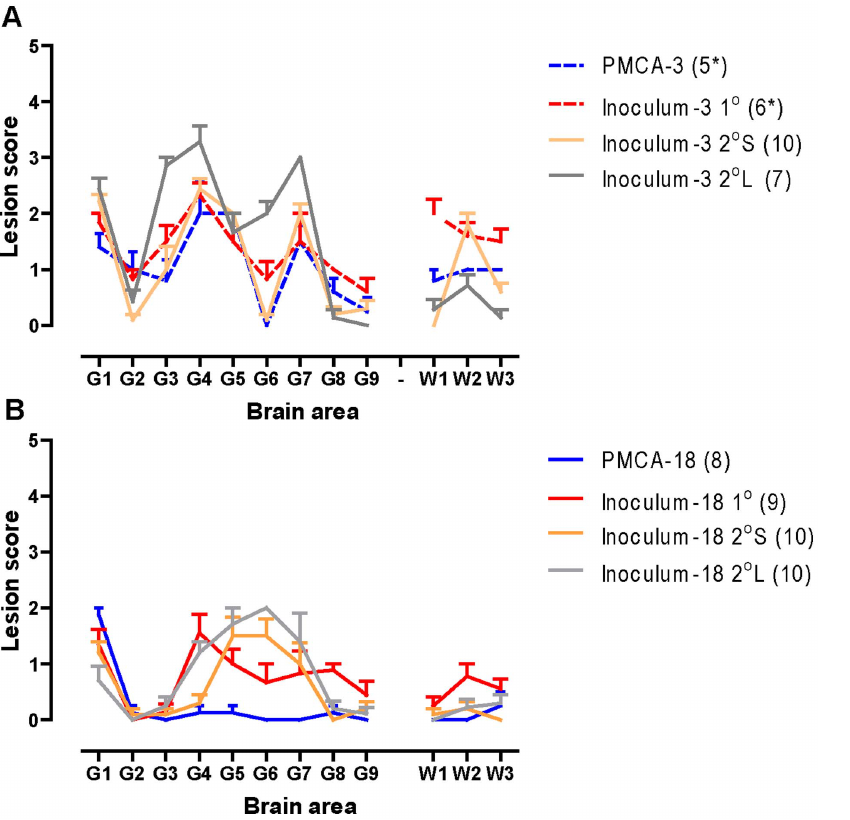
Figure 3. Lesion profiles of tg338 mice inoculated with non-amplified ovine PrP Sc and PMCA product. Lesion profiles were constructed from mice that were clinically and histopathologically positive. The number of mice used to construct each profile is shown in parentheses. (a) Lesion profiles of inoculum-3 and corresponding PMCA-3 mice. (b) Lesion profiles of inoculum-18 and corresponding PMCA-18 mice. (*) indicates that lesion profiles from five clinically and histopathologically positive mice were not available so the profile was constructed from all histopathologically positive mice, irrespective of clinical status for indication only.